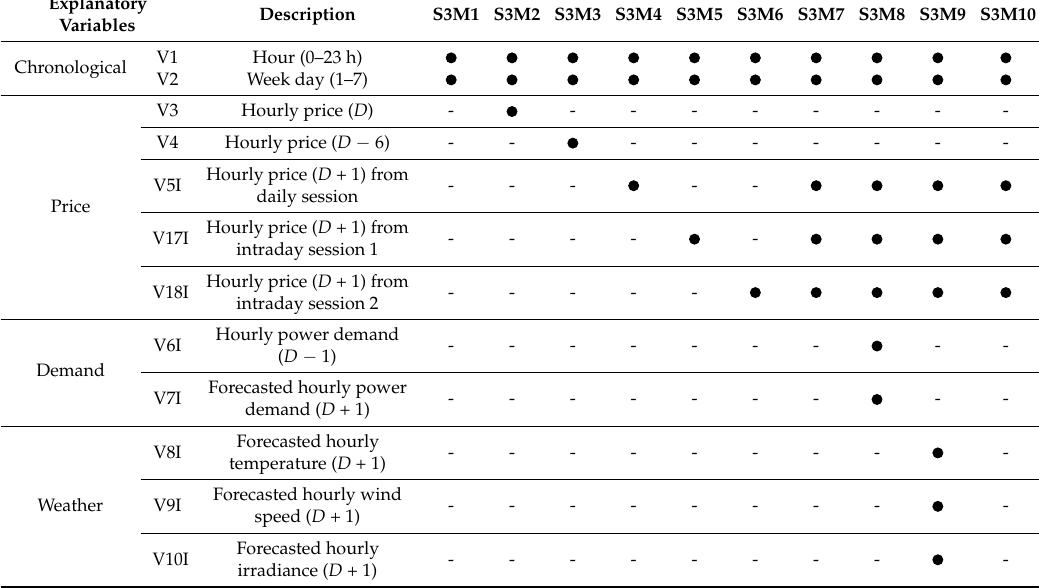
Table 10. ISMPF models for intraday session 3 and their MAPEs .